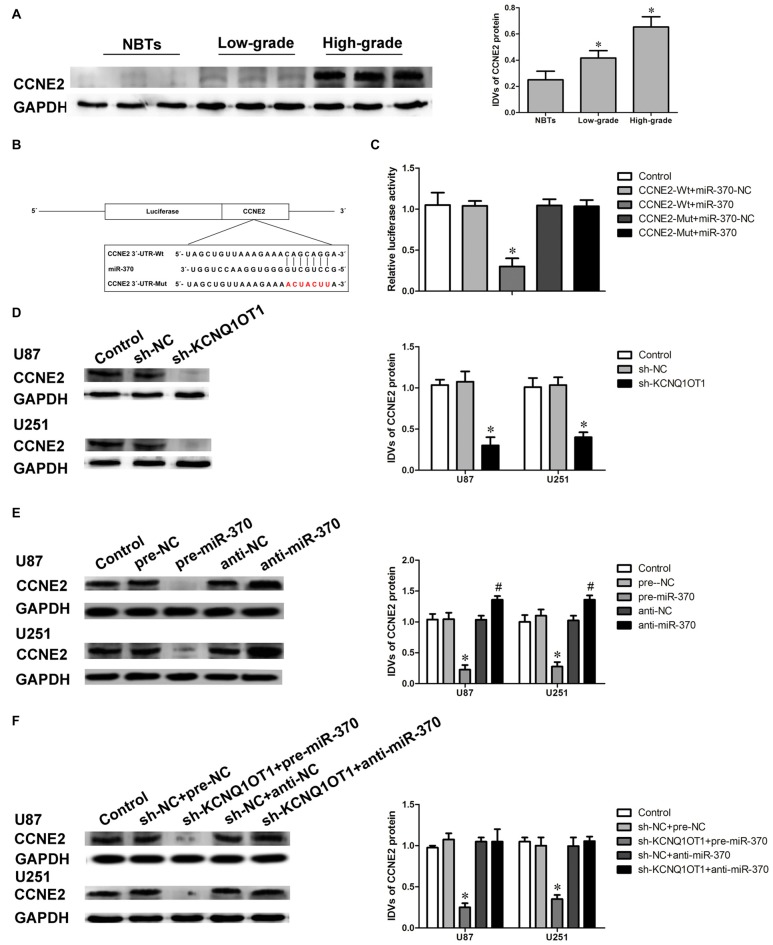
Cyclin E2 (CCNE2) was up-regulated in glioma tissues. CCNE2 was a target of miR-370, both KCNQ1OT1 and miR-370 could modulate CCNE2 expression. (A) CCNE2 protein expression levels in normal brain tissues and glioma tissues using GAPDH as an endogenous control. Representative protein expression and their integrated light density values (IDVs) of CCNE2 in normal brain tissues, low-grade glioma tissues ([WHO] I-II), and high-grade glioma tissues ([WHO] III-IV) are shown. Data are presented as the mean ± SD (n = 5, each group). *P < 0.05 vs. NBTs group. (B) CCNE2 harbored a putative miR-370 binding site, and designed mutant sequences were indicated. (C) Dual-luciferase reporter assay of HEK 293T cells co-transfected with CCNE2-Wt and miR-370-NC or CCNE2-Wt and miR-370, and CCNE2-Mut and miR-370-NC or CCNE2-Mut and miR-370. Data are presented as the mean ± SD (n = 5, each group). *P < 0.05 vs. CCNE2-Wt + miR-370-NC group. (D) Western blot analysis for CCNE2 in KCNQ1OT1 knockdown of human glioma cells using GAPDH as an endogenous control. Data are presented as the mean ± SD (n = 5, each group). *P < 0.05 vs. sh-NC group. (E) Western blot analysis for CCNE2 in miR-370 over-expression and miR-370 inhibition of human glioma cells using GAPDH as an endogenous control. Data are presented as the mean ± SD (n = 5, each group). *P < 0.05 vs. pre-NC group; #P < 0.05 vs. anti-NC group. (F) Western blot analysis for CCNE2 in co-transfected KCNQ1OT1 inhibition with miR-370 over-expression or miR-370 inhibition of human glioma cells using GAPDH as an endogenous control. Data are presented as the mean ± SD (n = 5, each group). *P < 0.05 vs. sh-NC + pre-NC group.